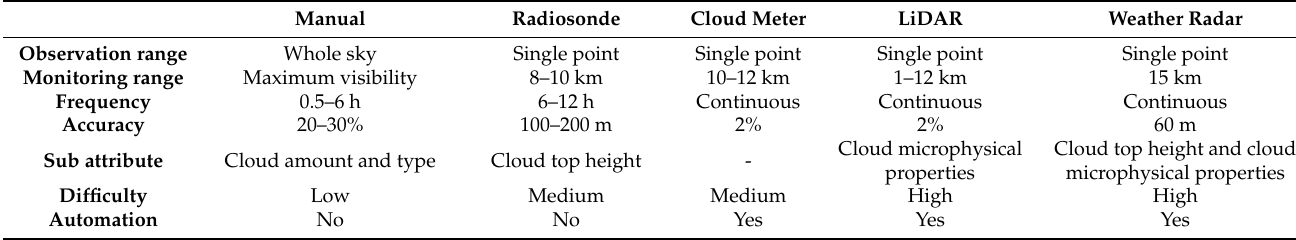
Table 1. Comparison of different cloud height observation methods.